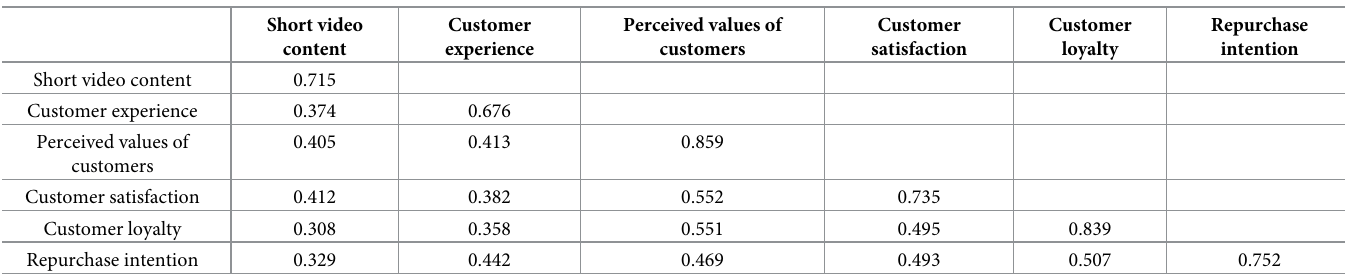
Table 4. Results of discriminant validity testing.